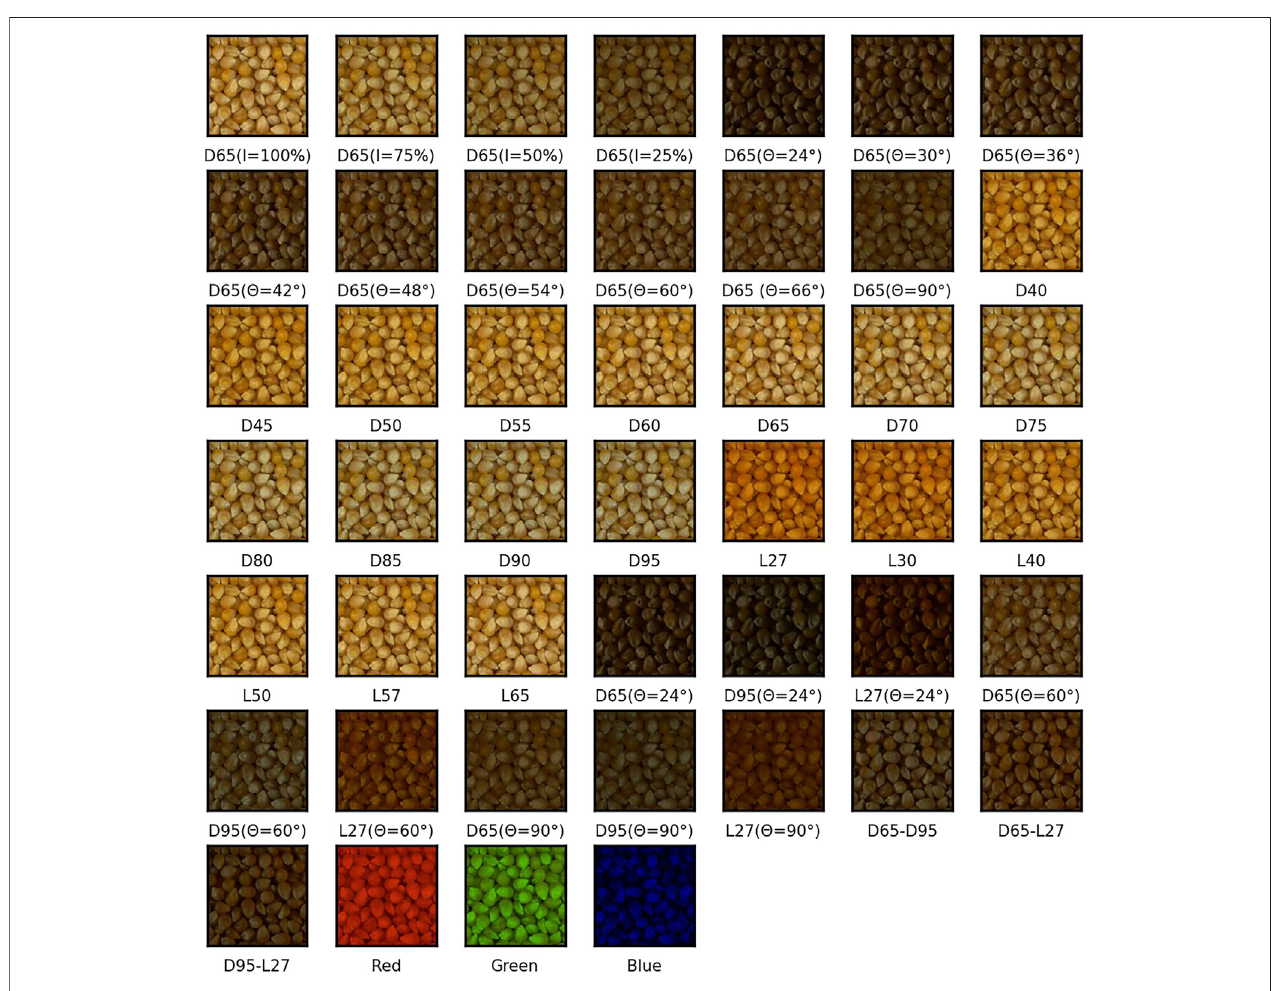
FIGURE 2 | Image of the original corn sample